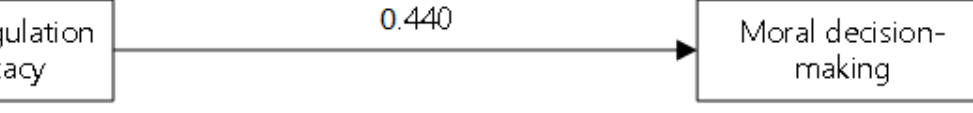
Figure 3. Influence of emotional regulation self-efficacy on moral